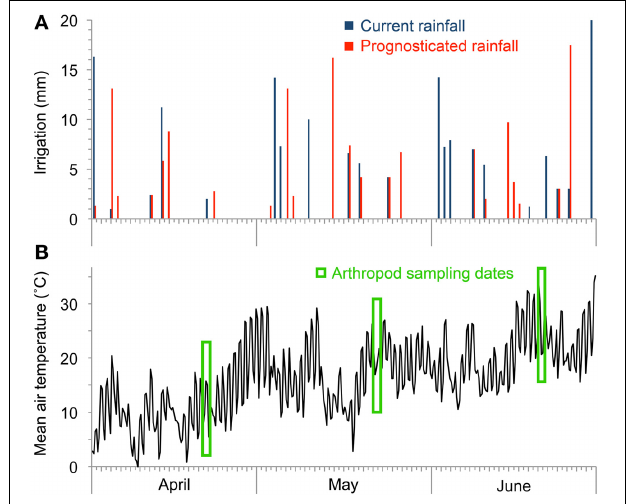
FIGURE 2 | Amount of applied rainfall applied onto treatment plots (A) and mean air temperature (B) during the course of the